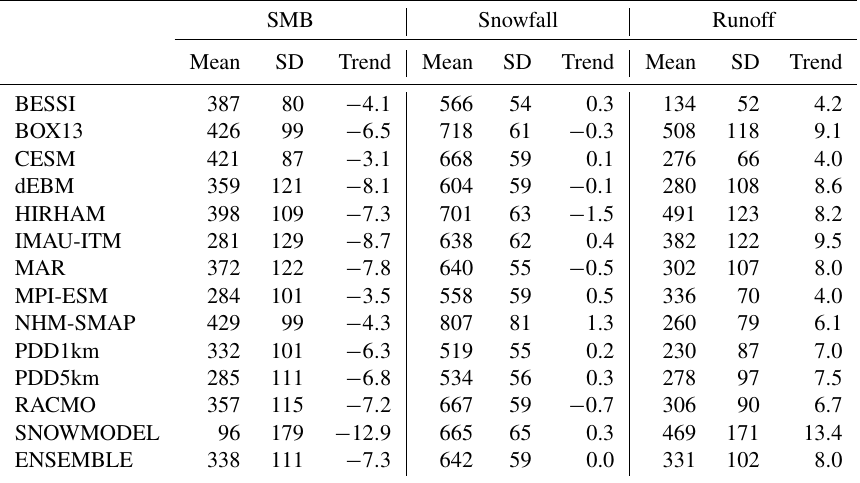
Table 2. Mean, interannual variability (standard deviation of the annual means) and linear trend of the main ice sheet SMB, snowfall and runoff in (Gtyr − 1 ) over 1980–2012 simulated by the 13 models.